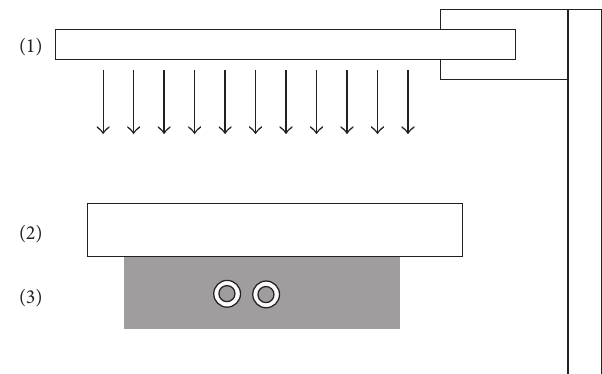
Figure 1: Schematic of fluidized bed photoreactor. (1) Adjustable UVC lamp. (2) Rectangular cubic reactor. (3) Magnetic